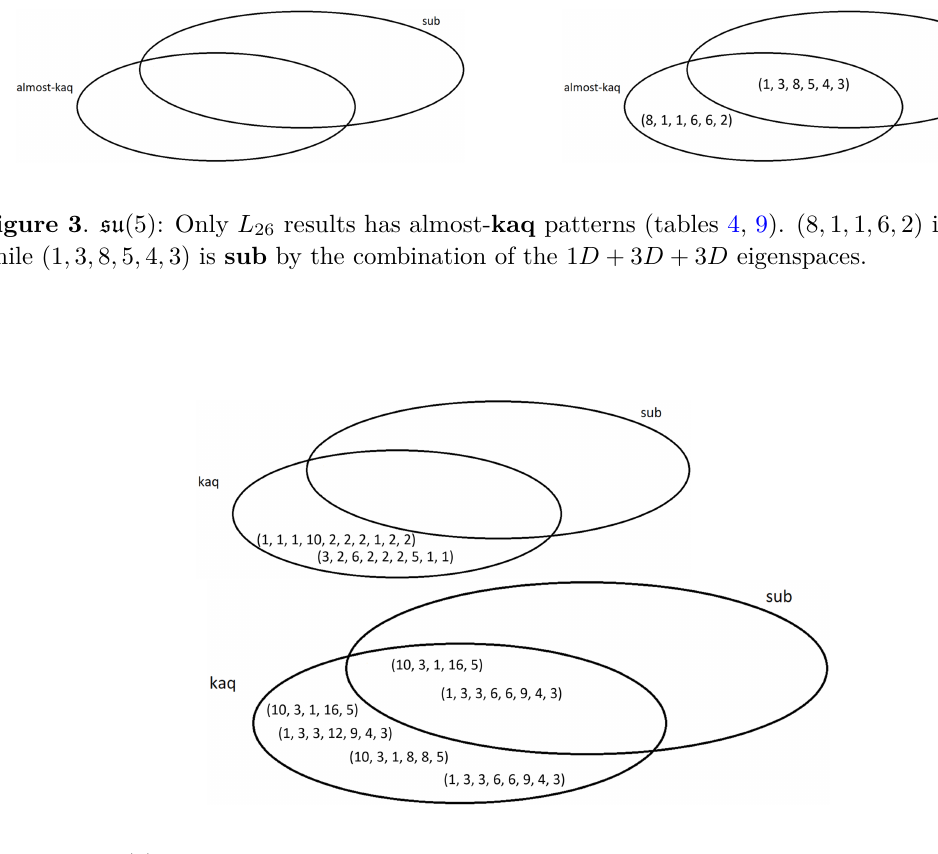
Figure 4 . su (6) : There are more non- sub patterns than sub . Using tensor basis, we obtain only non- sub solutions such as (10 , 3 , 1 , 16 , 5) , however the same pattern obtained by using Gell-Mann basis, gives only sub solutions (by the combination of 10 D + 3 D + 1 D or 10 D + 3 D eigenspaces), hence why this pattern appears